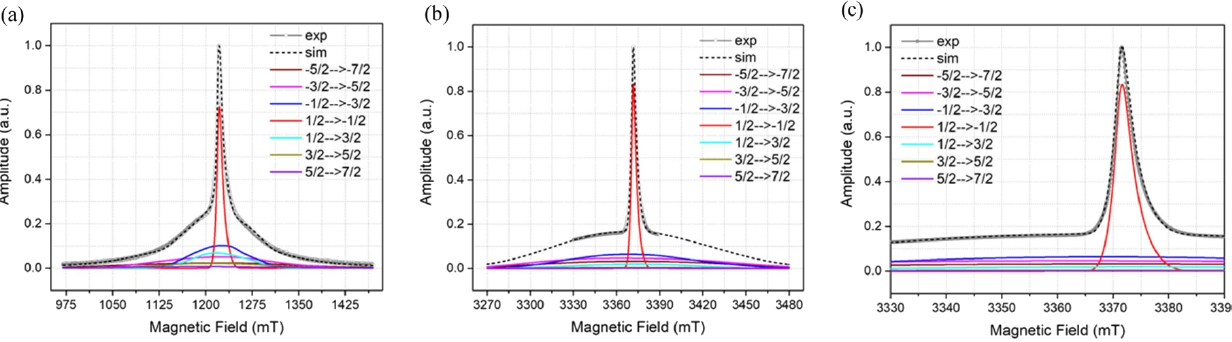
Figure 2. Simulated and experimental ED-FS spectra of the Gd ruler (6.0nm) with the associated sub-spectra of the individual transitions, (a) at Q-band, (b) at W-band with wide magnetic field ranges and (c) at W-band with narrow magnetic field range respectively. The parameters used in the simulation are D = 1060MHz, D strain = 850MHz, E = 320MHz and E strain =